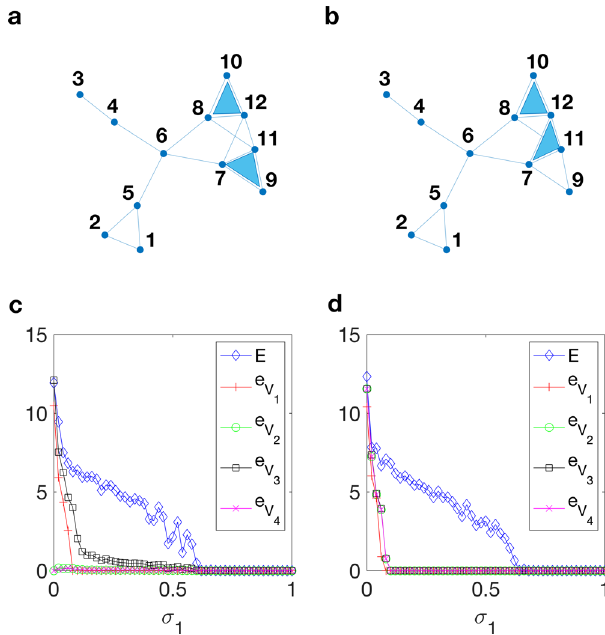
Fig. 7 Cluster synchronization in simplicial complexes of Rössler oscillators. a A simplicial complex where the symmetries of L ð 2 Þ do not match those of L ð 1 Þ . b A simplicial complex where the symmetries of L ð 2 Þ match those of L ð 1 Þ . c Synchronization error as a function of σ 1 for the simplicial complex ia. d Synchronization error as a function of σ 1 for the simplicial complex in panel b. In both cases, σ 2 has been set to σ 2 =